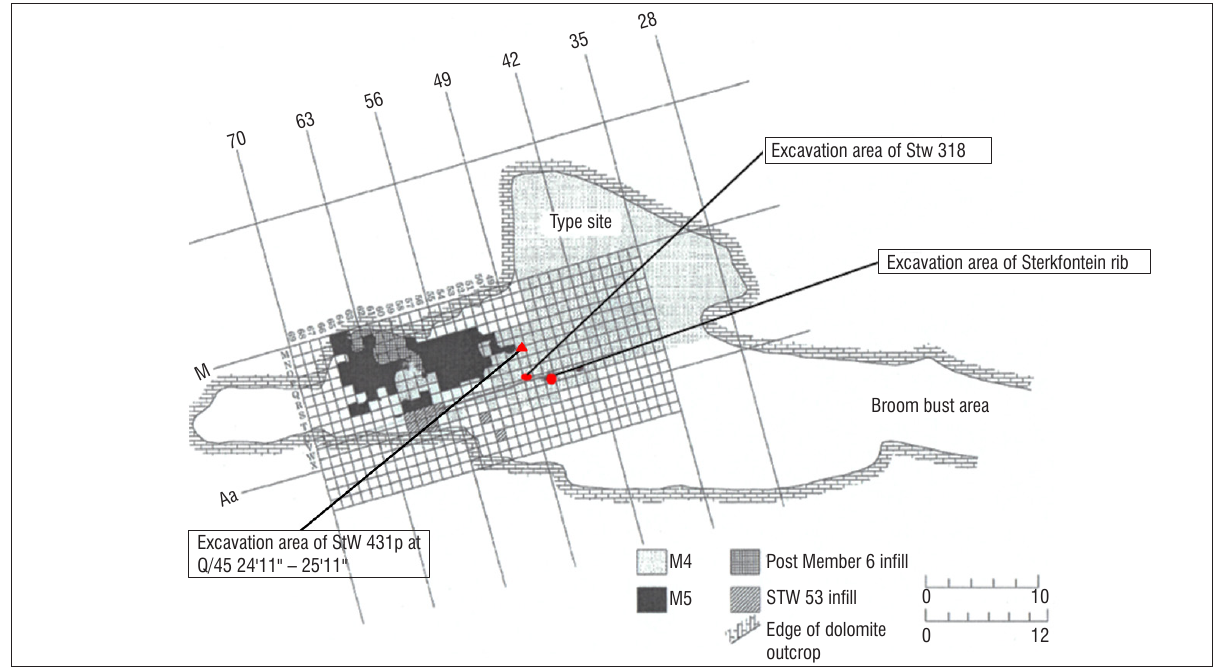
Stratigraphy of Sterkfontein Members 4 and 5, indicating the locality of excavation of StW 670 and StW Linear measurements was calculated from the average of three measurements in order to reduce intra-observer error. 1,2,25 The measurements are given in Table 1. Linear measurements taken on StW 670 were carried out on the original remains. The linear measurements taken were: head height Linear measurements taken on StW 670 (superoinferior diameter of the rib head), head width (anteroposterior diameter of the rib head), neck length (distance from the medial-most point on the rib head to the medial-most point on the articular facet of the tubercle) and neck width (taken midway between the rib head and articular tubercle in anteroposterior dimension). 2,9,25 Each measurement